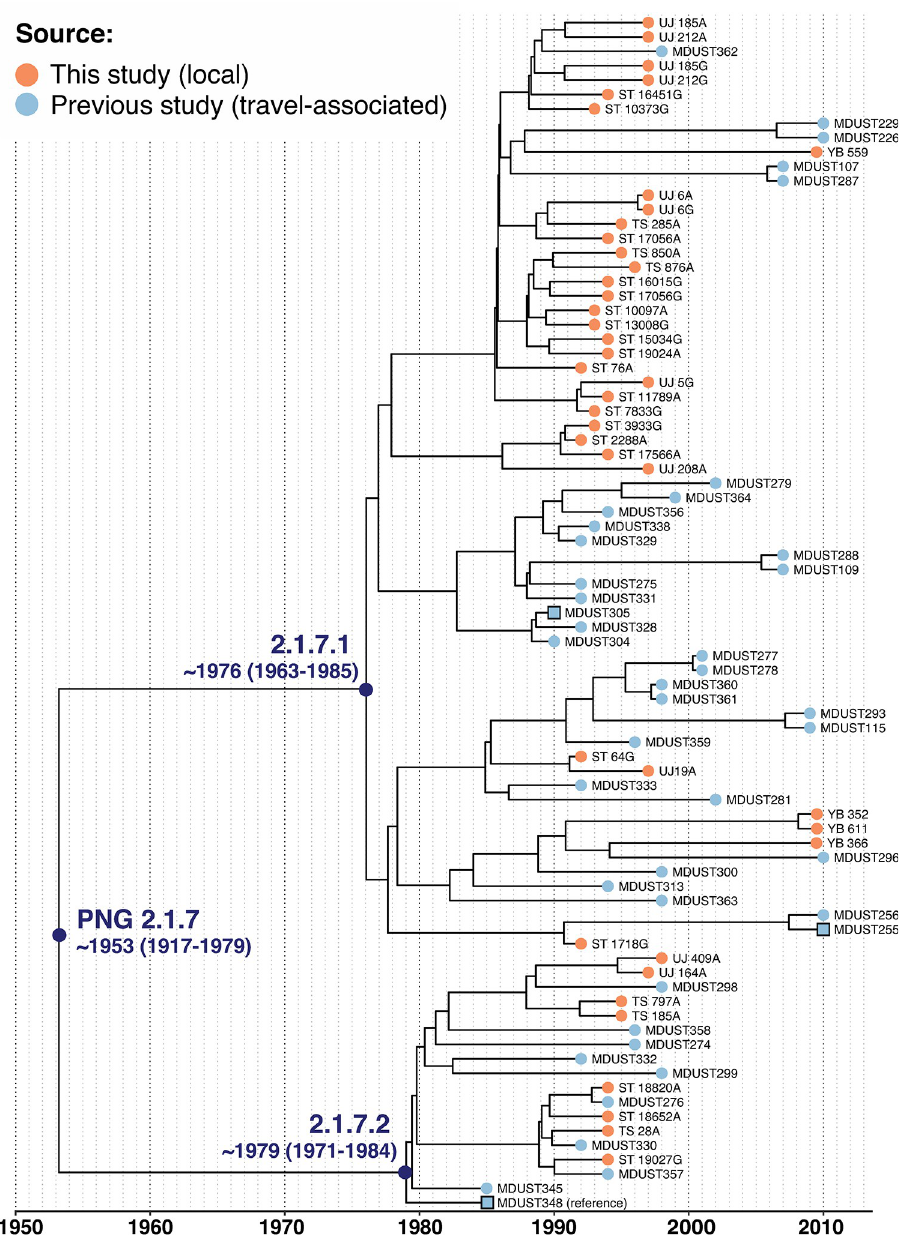
Fig 1. Maximum clade credibility tree inferred from all available (n = 83) PNG 2.1.7 S . Typhi using BEAST2. Tip colours indicate isolate source as per inset legend, branches are labelled by S . Typhi genotype. Square nodes indicate the reference sequence and other completed genomes. Divergence dates for PNG genotype 2.1.7 and sublineages are labelled (95% highest posterior density in brackets). Interactive phylogeny available at: https://microreact.org/project/